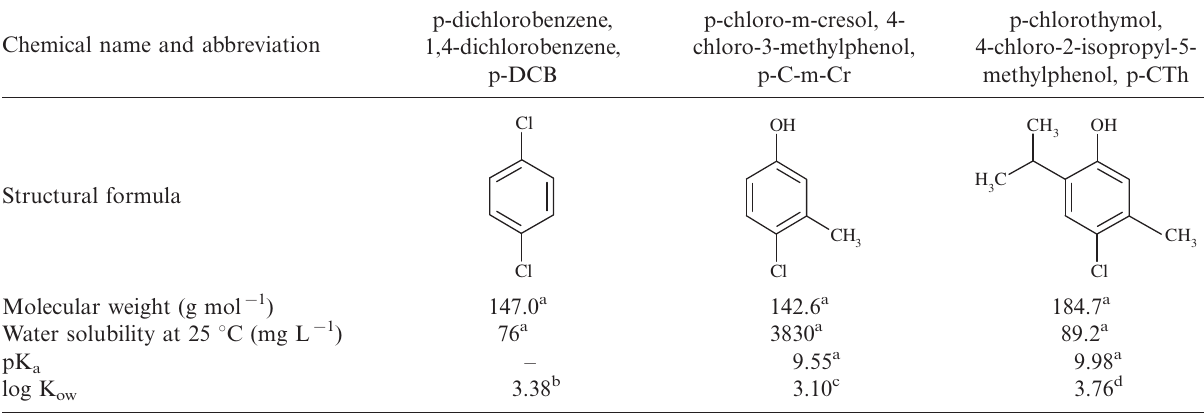
Table 2. Chemical-physical properties (molecular weight, water solubility, log K ow and pK a ) of the target compounds Chemical name and abbreviation